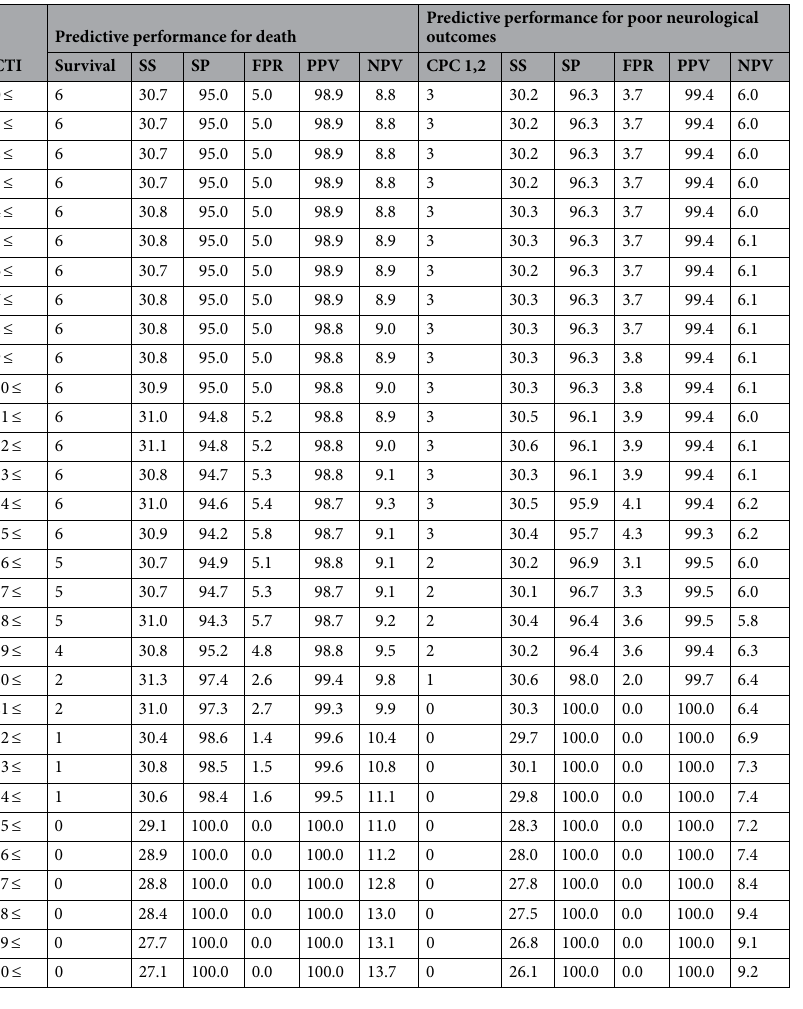
Table 4. The cutoff compression time interval in the group met the KoCARC TOR rule and its predictive performance for death and poor neurological outcomes at hospital discharge. Variables are presented as numbers and percentages. The survival number and CPC 1 and 2 indicate patients who met the KoCARC TOR rule but survived and showed good neurological outcomes. KoCARC, Korean Cardiac Arrest Research Consortium; TOR, termination of resuscitation; CTI, compression time interval; SS, sensitivity; SP, specificity; FPR, false-positive rate; PPV, positive predictive value; NPV, negative predictive value.